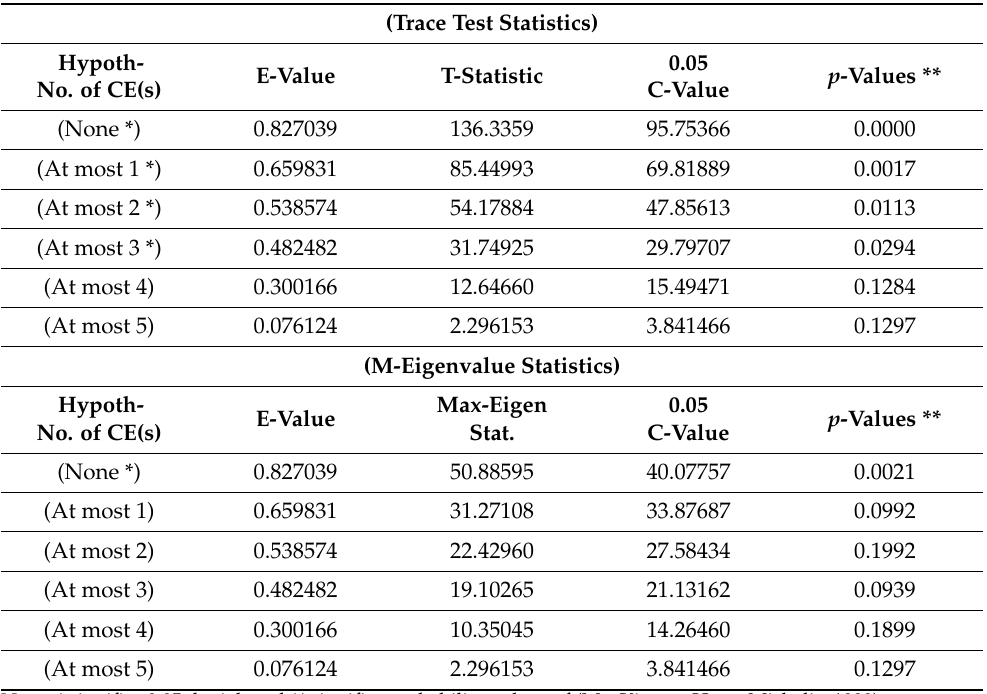
Table 7. Johansen cointegration